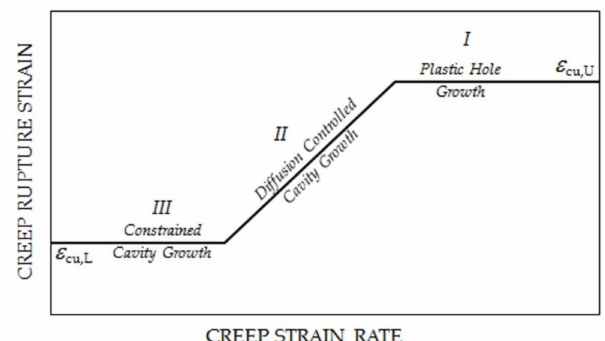
Figure 4. Variation of creep rupture strain with creep strain rate and the influence of damage mechanism on creep ductility (the indicated regime numbers coincide with those in Figure 3a).